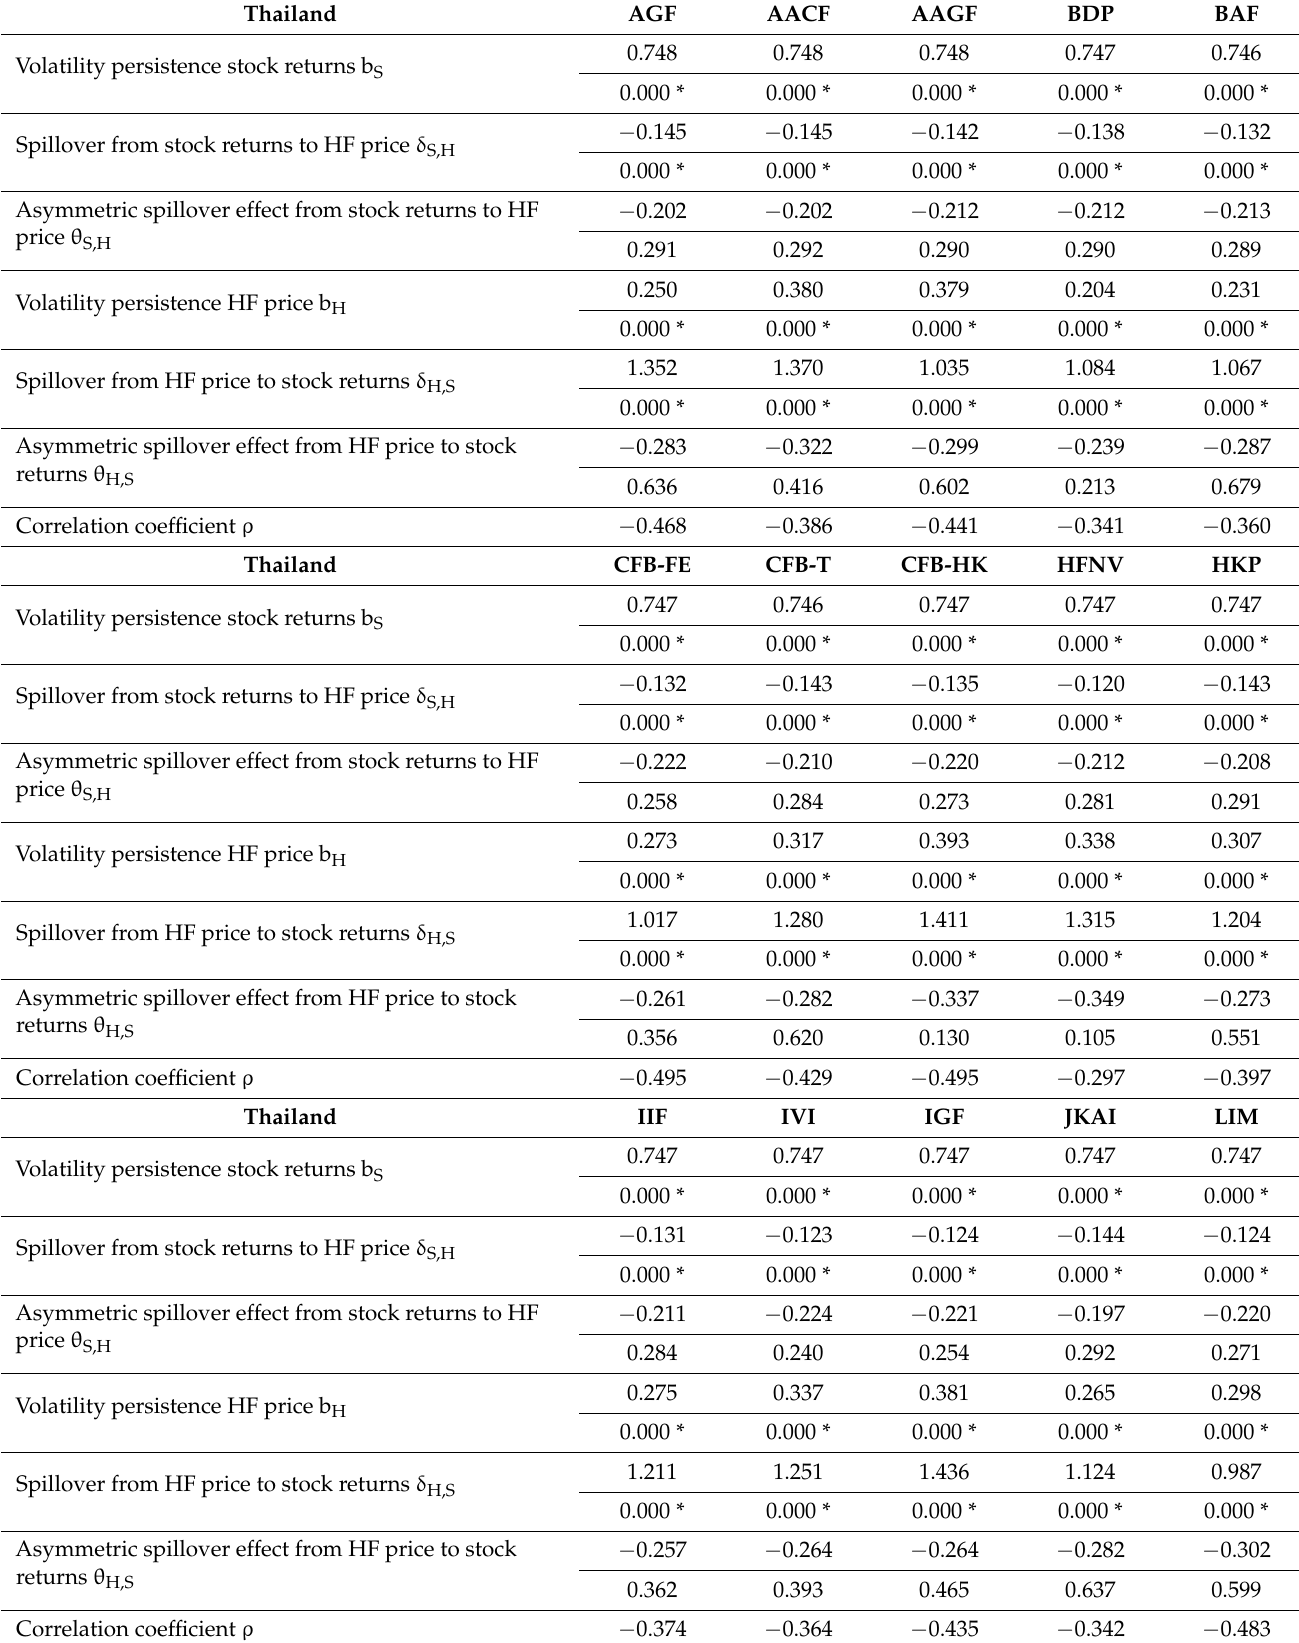
Table 10. Volatility spillover between the Thailand Stock Market (SET) and Hedge Fund